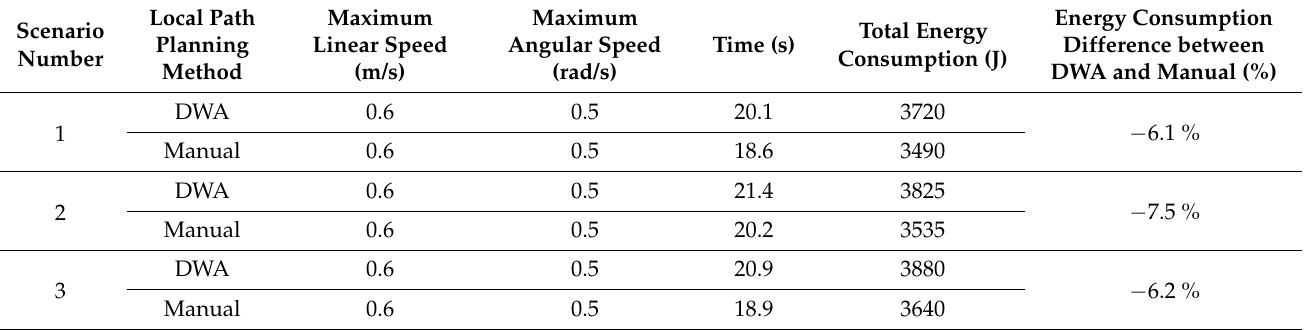
Table 3. Summary of the simulation results.